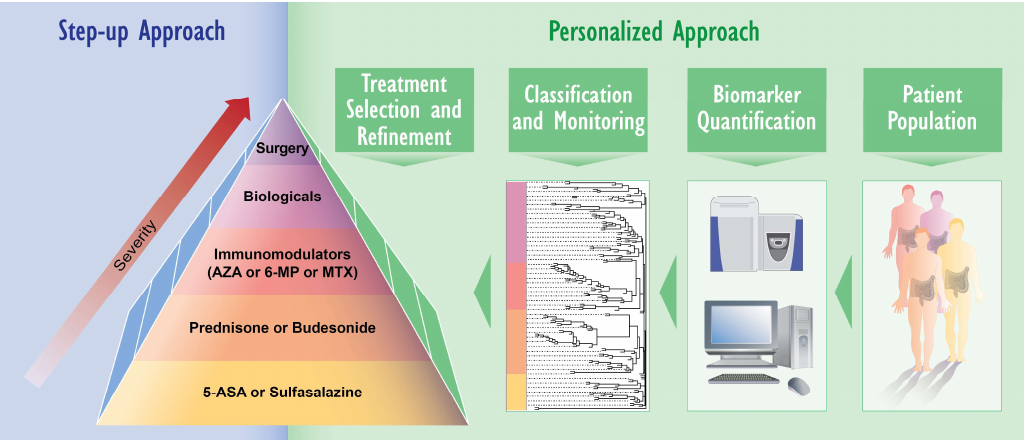
Figure 5. Step-up and personalized treatment approaches for IBD. In the classical “step-up” approach to IBD treatment, treatments are selected and aligned with disease severity, from the bottom to the top of the pyramid. The proteomics and lipidomics approaches discussed in this review will contribute to the development of personalized treatment of IBD patients. The discovery of predictive biomarkers will support the matching of personalized treatment, continuous monitoring of treatment responses, and further treatment refinements.